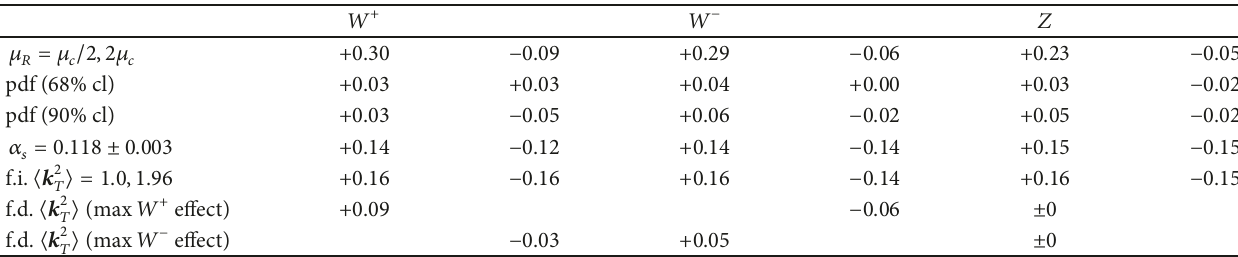
Table 1: Summary of the shifts in GeV induced on the peak position in 𝑞 𝑇 spectra of 𝑊 ± /𝑍 , generated by different effects. “f.i.” stands for flavour-independent, whereas “f.d.” for flavour-dependent. “Max 𝑊 ± ” effect indicates the maximum shift induced on the peak position of the 𝑊 ± 𝑞 𝑇 spectrum by flavour-dependent variations of ⟨ 𝑘 2 𝑇 ⟩ that keep the peak of the 𝑍 𝑞 𝑇 spectrum unchanged. For the values of the flavour-dependent non-perturbative parameters we refer the reader to